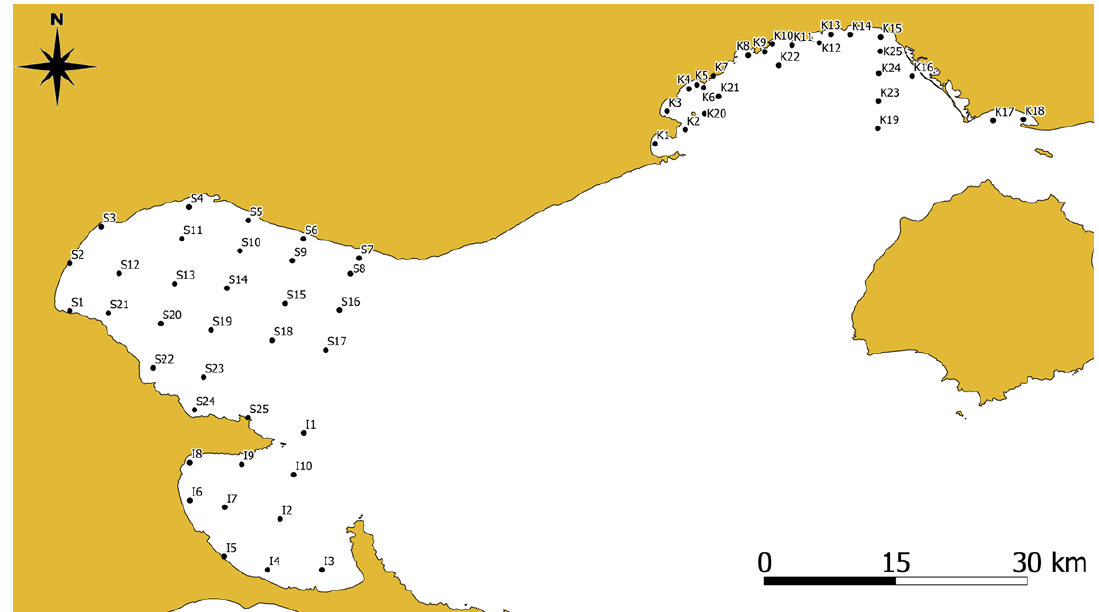
Figure 2. Map of the 60 sampling sites at the three gulfs at North Aegean Sea: Kavala Gulf (KAV 1 – 25); Strymonikos Gulf (STR 1 – 25) and Ierissos Gulf (IER 1 – 10).